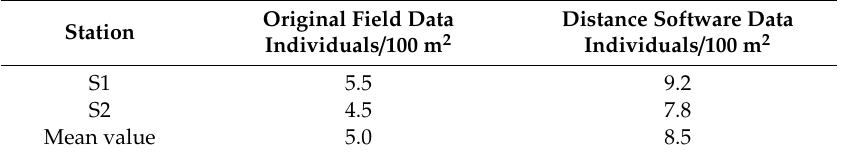
Table 2. Population density of Sphaerechinus granularis in S1 and S2 sampling stations of Pagasitikos Gulf according to original field and Distance software data.